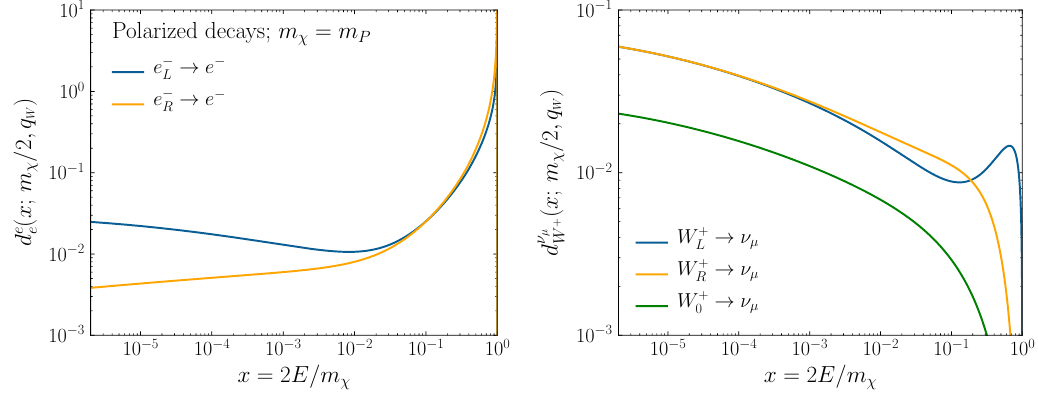
Figure 5 . Example FFs obtained using the DGLAP evolution and soft-coherence correction out- lined in appendix B. In this figure we have chosen to highlight the generation of polarization due to the chiral nature of the SM. In particular, on the left we see that left and right handed electrons evolve to produce a significantly different distribution of e = e that all three polarizations of the W evolve differently. In both cases the evolution is performed for a Planck scale mass DM particle down to the weak